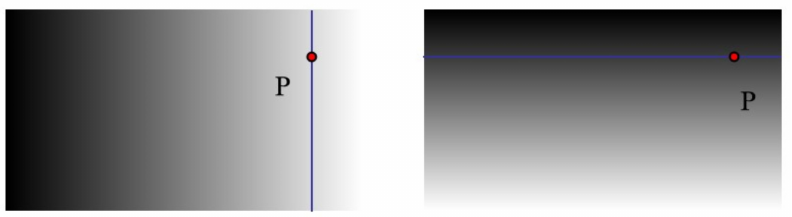
Figure 6. Vertical phase and horizontal phase grayscale distribution map.